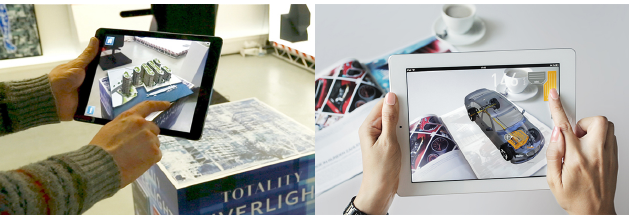
Figure 1. The left image [10] shows three dimensional information regarding user’s 3D point of view gives useful insights about how to improve application user experience. Moreover, two dimensional information is very useful to figure out parts of model which are catching the user attention as showed in right image